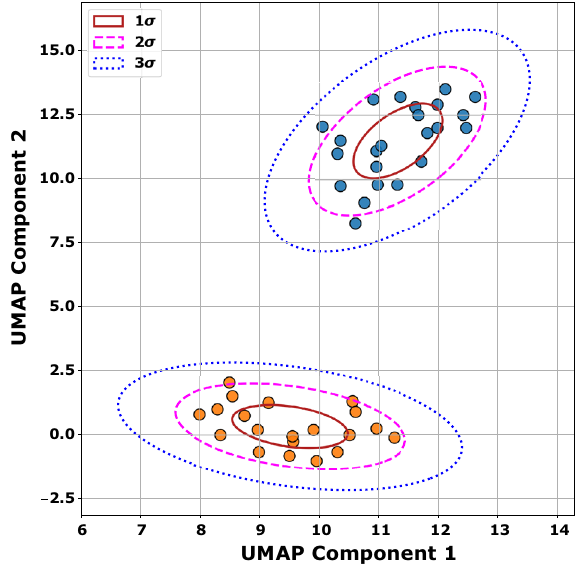
Figure 2. Uniform Manifold Approximation and Projection (UMAP) of component 1 versus component 2 showing two clusters of participants with differentially expressed genes following poly(I:C) stimulation. Cluster 1 (blue circles). Cluster 2 (orange circles). Ellipses indicate the boundaries of one standard deviation (σ) by a solid red line, two σ by a pink dashed line, and 3σ by a blue dotted